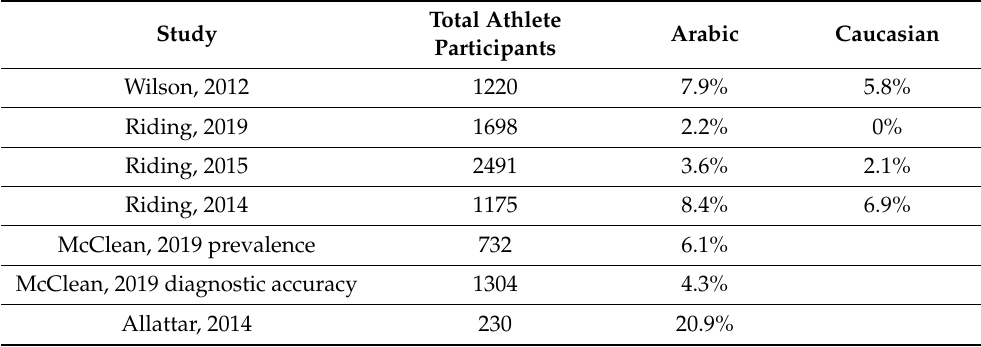
Table 6. Percentages of abnormal ECGs in Arabic athletes compared to Caucasian